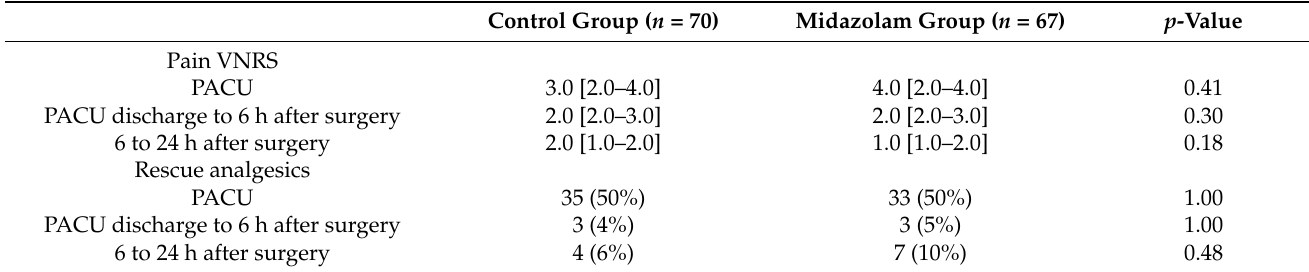
Table 3. Postoperative